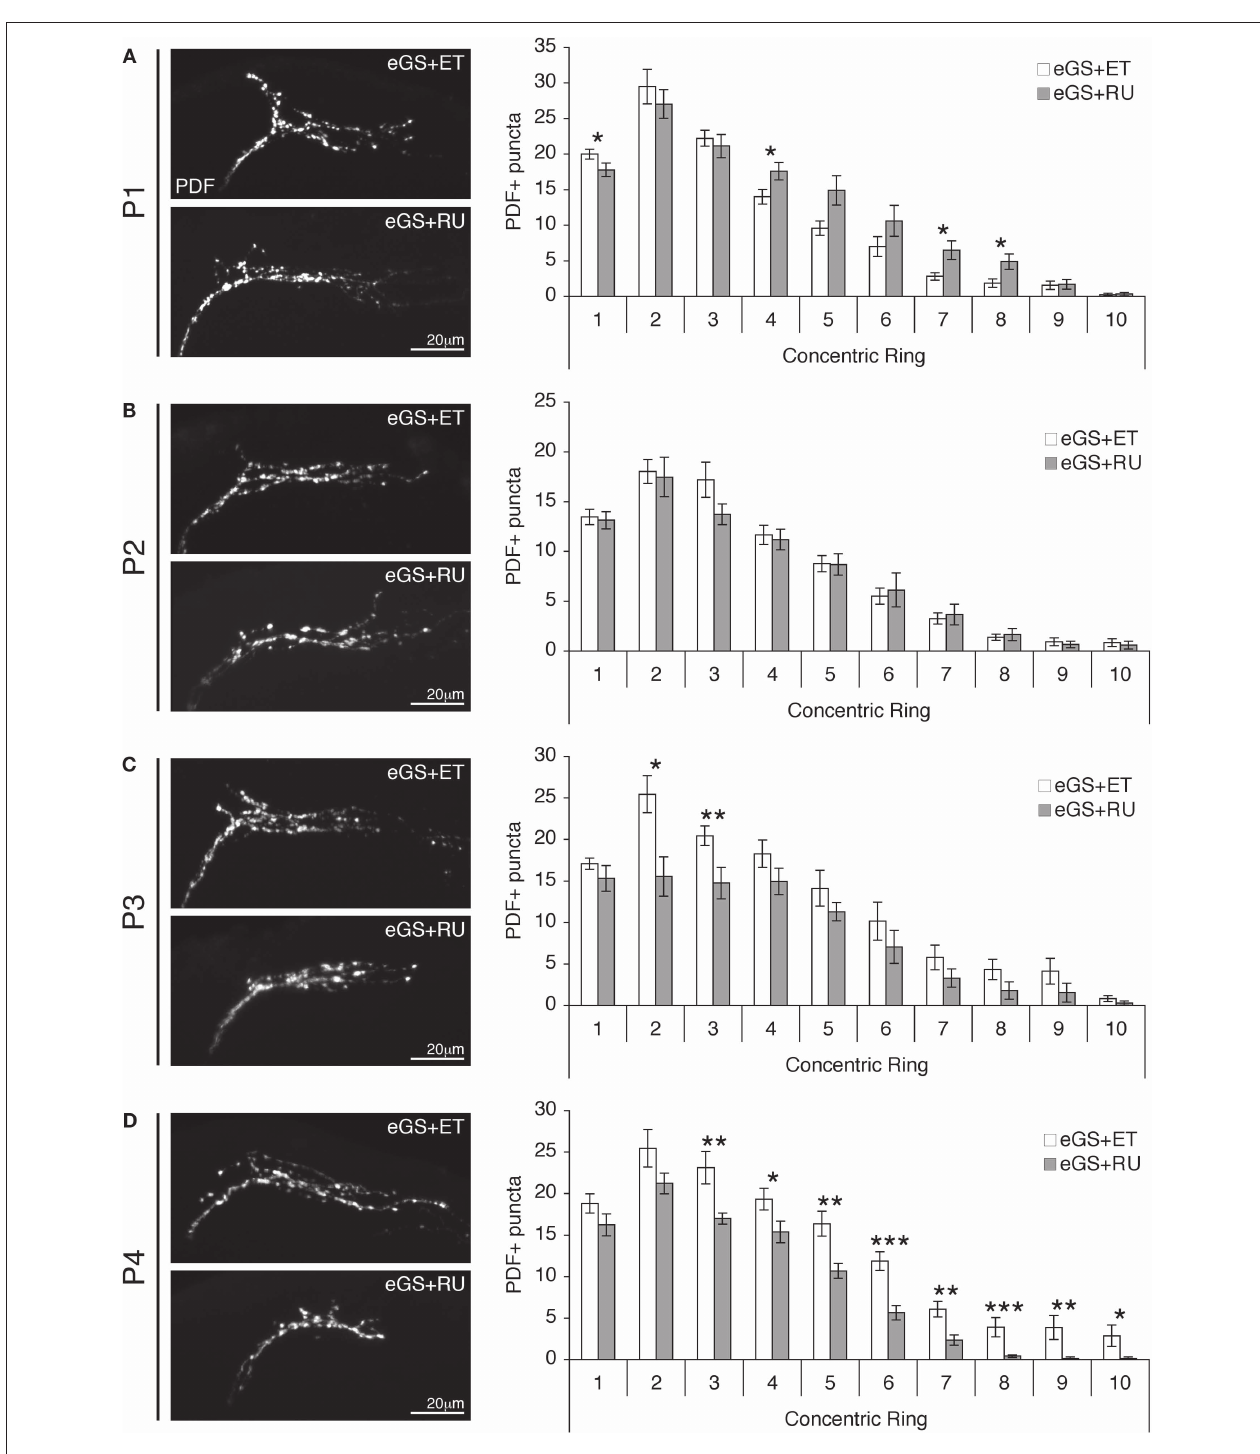
FIGURE 4 | dFMRP induction only during late brain maturation restores after P2 inductive treatment with ethanol vehicle (eGS + ET) or RU486 normal sLN synaptic architecture. (A) Representative images of adult sLN (eGS + RU). At right, quantifi cation showing no change with dFMRP induction. v v synaptic arbors immunostained for PDF after pupal day 1 (P1) inductive (C,D) Representative images are displayed of adult sLN treatment with ethanol vehicle (eGS + ET) or RU486 (eGS + RU). At right, immunostained for PDF after P3 (C) or P4 (D) treatment with ethanol vehicle quantifi cation from the PDF-adapted modifi ed Sholl Analysis, indicating a (eGS + ET) or RU486 (eGS + RU). Quantifi cations show signifi cant rescue of moderately exacerbated mutant phenotype. Signifi cance levels: p < 0.05 (*). the synaptic defects. Signifi cance levels: p < 0.05 (*); p < 0.01 (**); (B) Representative images of adult sLN synapses immunostained for PDF p < 0.001 v